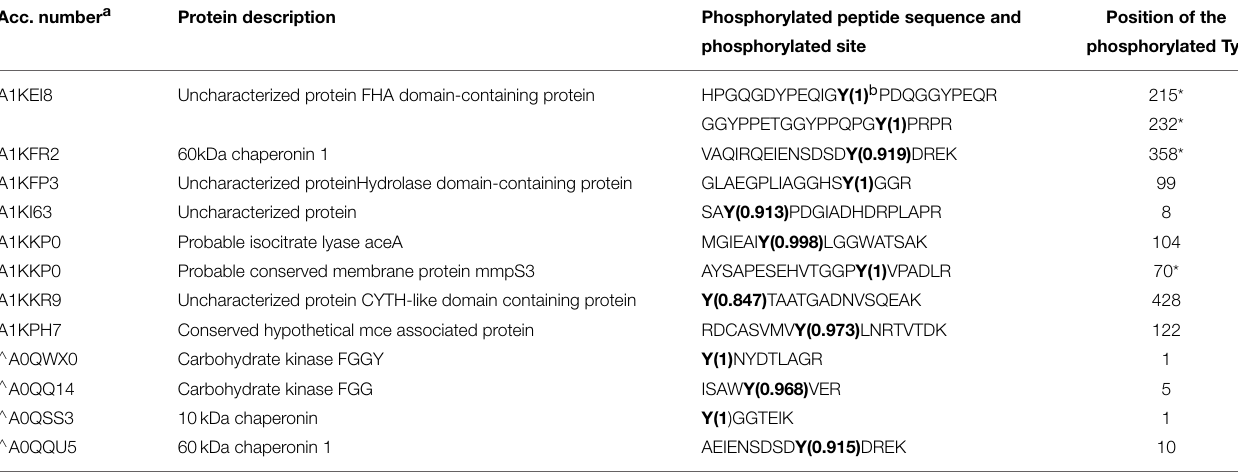
TABLE 1 | List of Tyr phosphorylated proteins/sites identified in M. bovis BCG and M. smegmatis . Acc. number